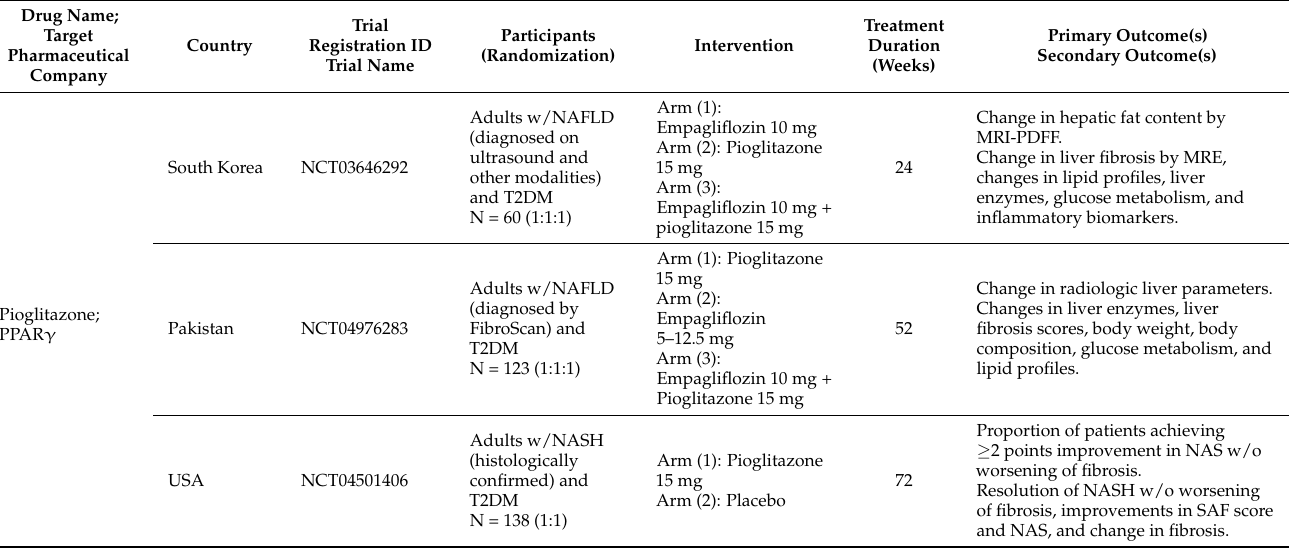
Table 2. Ongoing interventional trials of PPAR-targeted therapy in